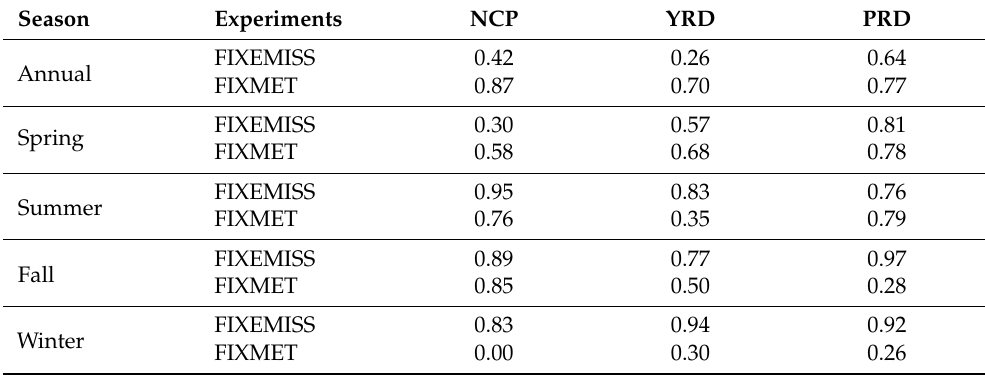
Table 2. Correlation coefficients of PM 2.5 /AOD ( η ) in the BASE experiment with those in FIXEMISS and